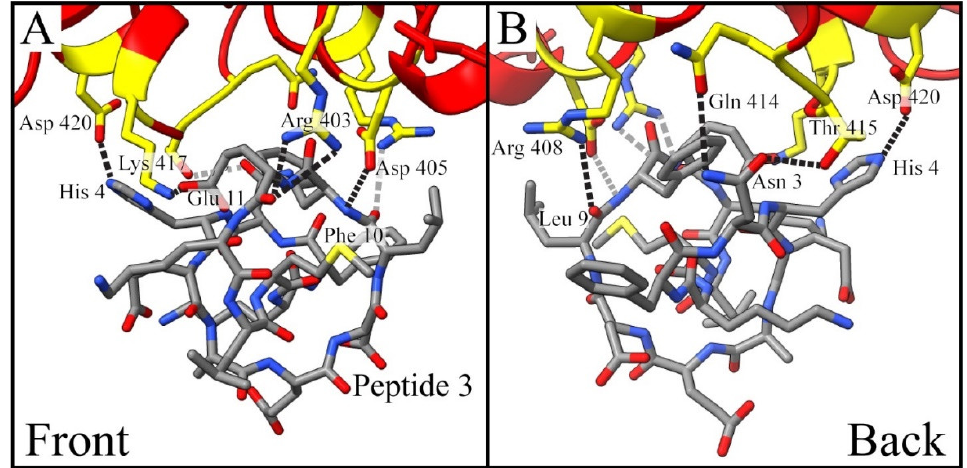
Figure 4. The molecular docking modeling of the SARS-CoV-2 spike protein RBD with Peptide 3. The spike protein is colored red with the nine residues that could provide avenues for binding to the peptide highlighted in yellow. Heteroatoms are colored accordingly on the highlighted residues and the peptide sequence. The hydrogen atoms have been removed for clarity. View of the docking shown from the front ( A ) and back ( B ) as illustrated in ChimeraX software. The black dashed lines represent the interactions in the foreground of the image, while the gray dashed lines are in the background.